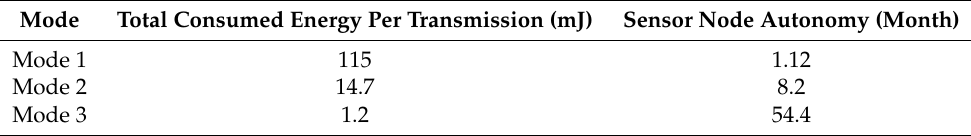
Table 8. Comparison between different LoRaWAN modes (using Scenario